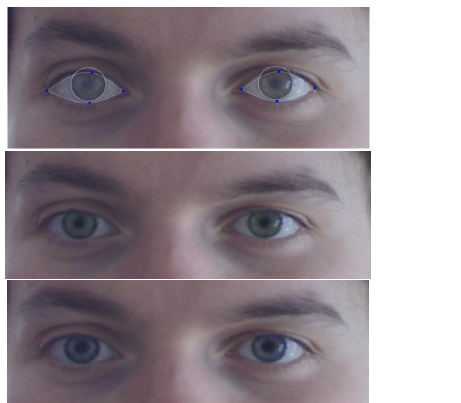
Figure 24: different contact lenses colors are simulated: dark-green, hazel, natural green, and ocean blue respectively.